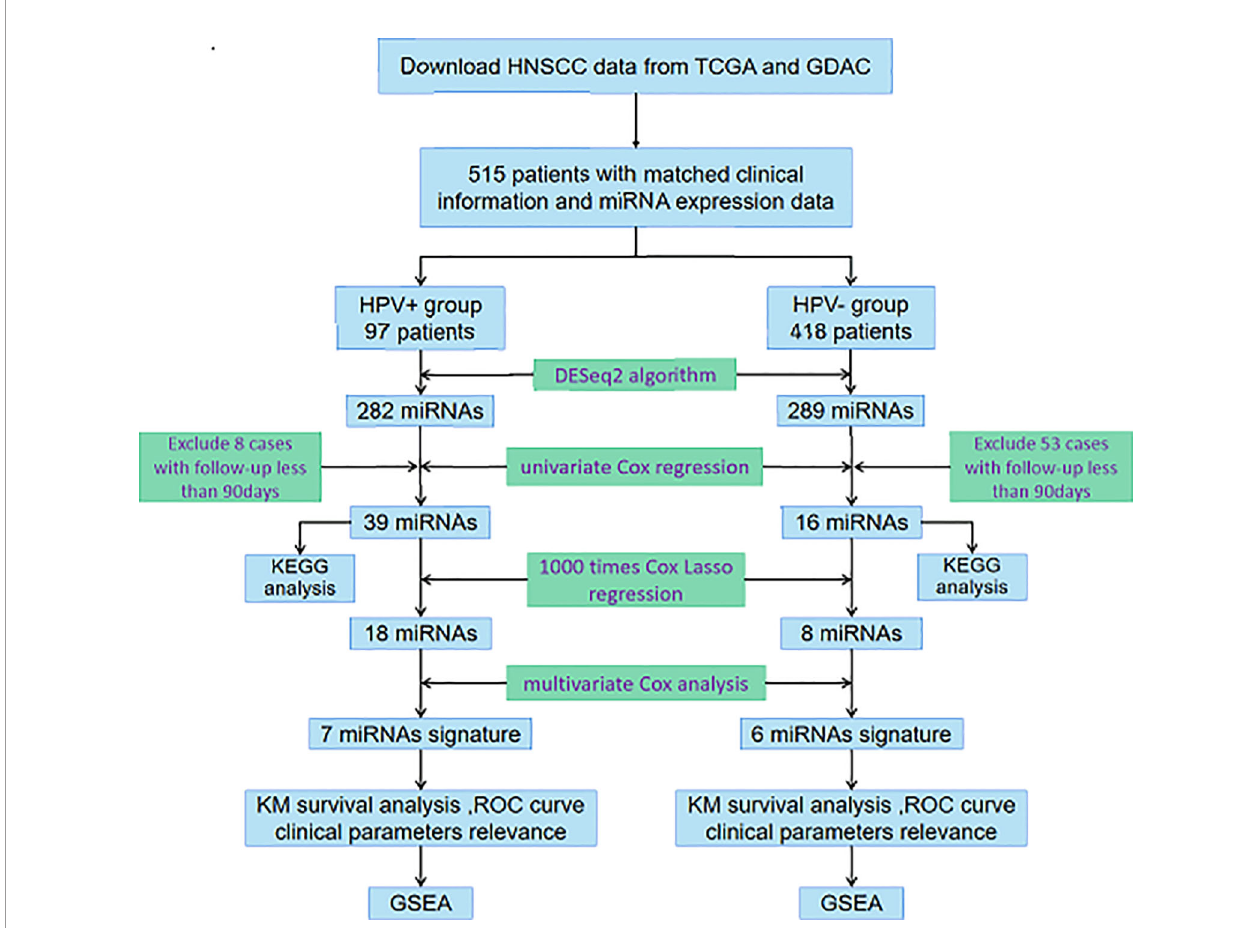
FIGURE 1 | Flowchart illustrates the exploration procedure for the HNSCC prognostic miRNAs with division of HPV